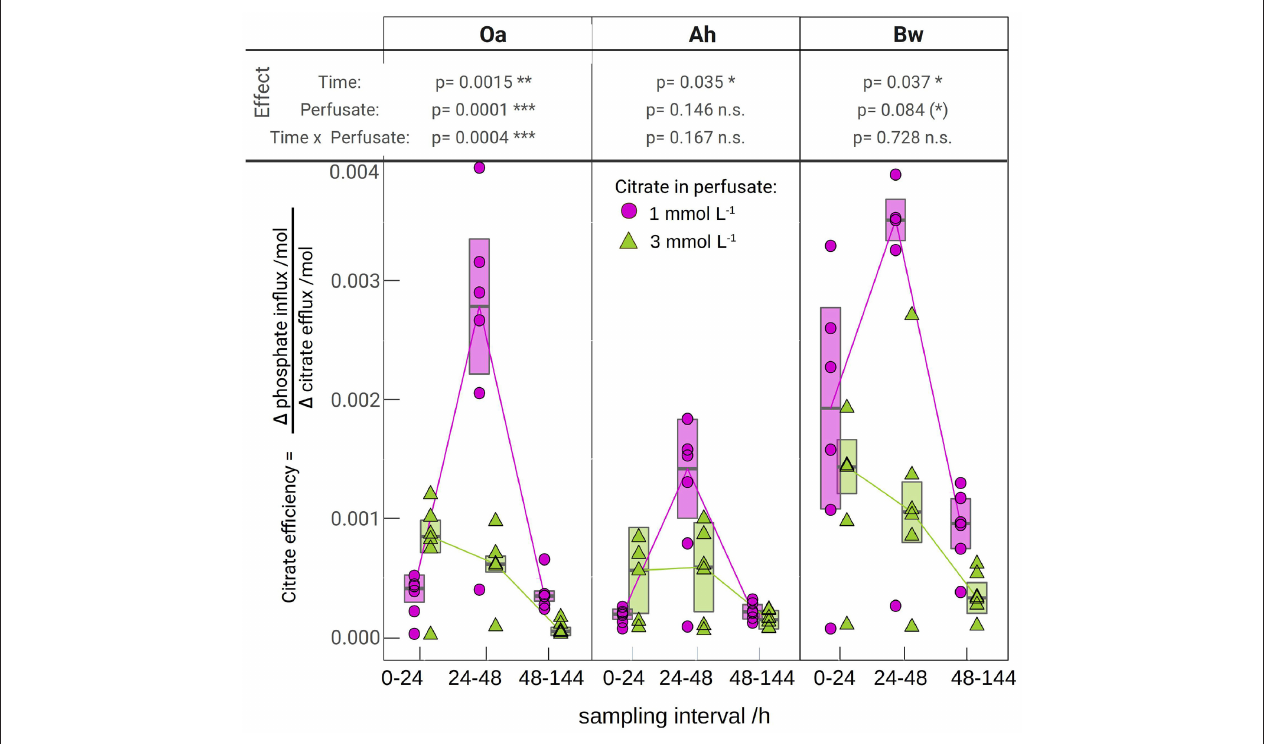
FIGURE 3 | The molar efficiency of citrate to release phosphate, calculated as the ratio of flux changes between the respective citrate perfusate and the control (Equation1). The lines are connecting medians indicating the temporal pattern. The error bars limit the approximated 95% confidence limits of the medians, the tabled p -values come from a robust mixed 2-way anova (c.f. that was applied separately for each soil horizon. Significance of p -values is symbolized by: (*) < 0.1, * < 0.05, ** < 0.01, *** < 0.001).